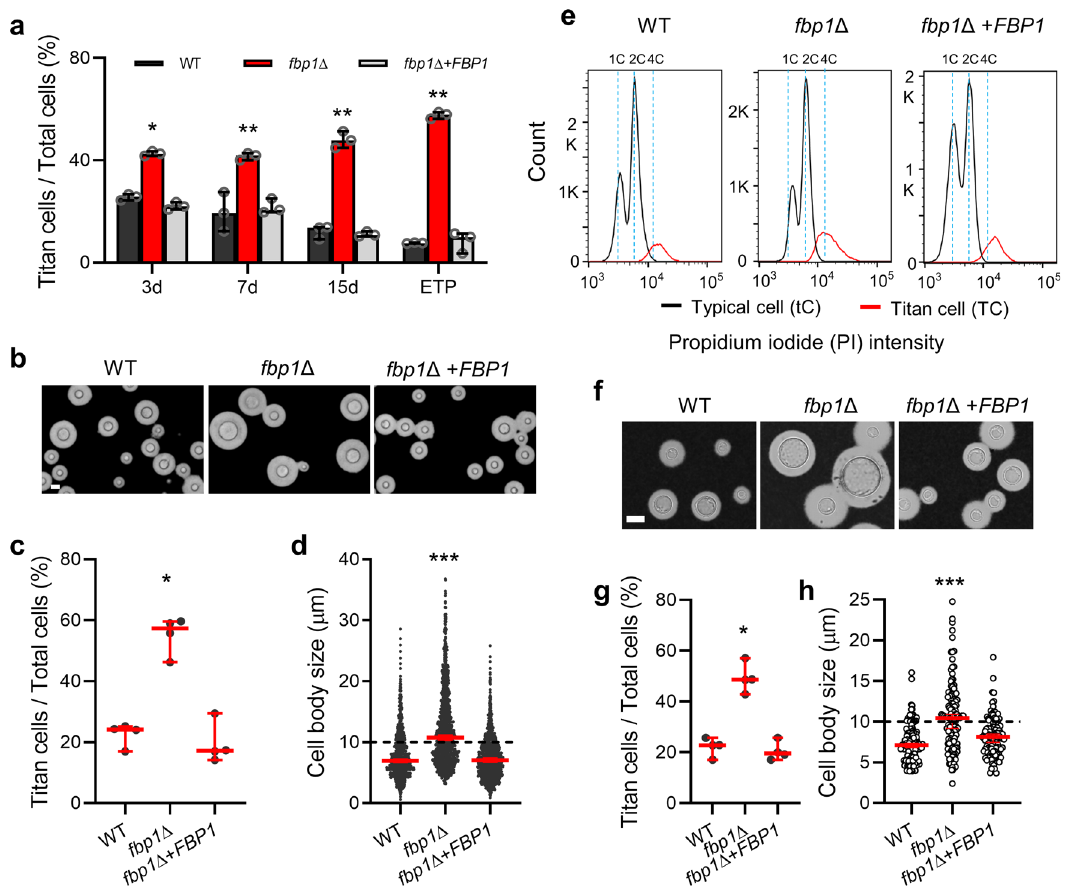
Fig. 1 | The E3 ligase Fbp1 is required for cell size control in C. neoformans . a Percentage of titan cell in the lungs during Cryptococcus infection. Error bar indi- cates95%con fi denceintervalofthemedianfor3independentexperiments.Statistical analysisforallmeasurementsinthis fi